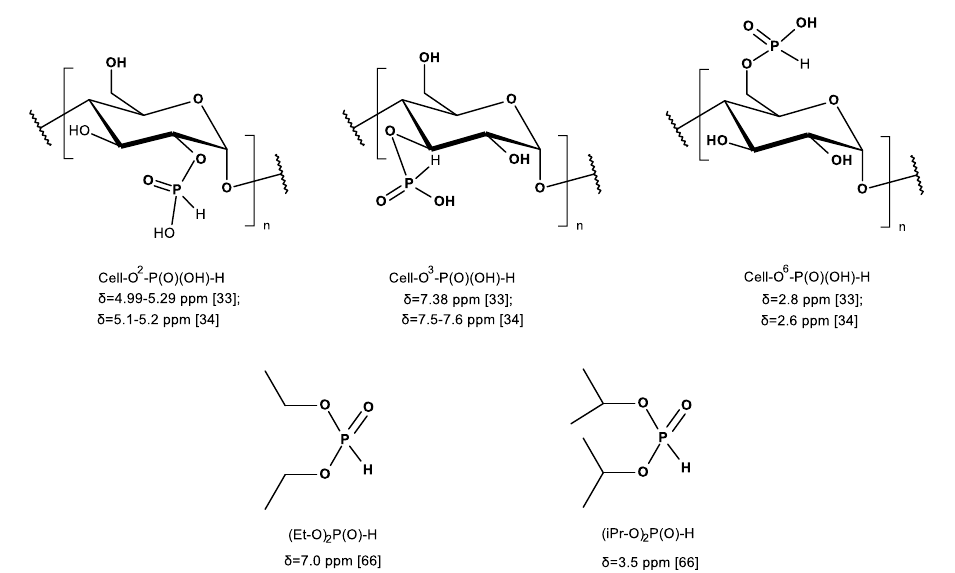
Figure 6. Structures of Cell- O i -P(OH)-H and representative dialkylphosphates (III) with primary and secondary alkoxyl, and corresponding literature 31 P-NMR chemical shifts [ppm].